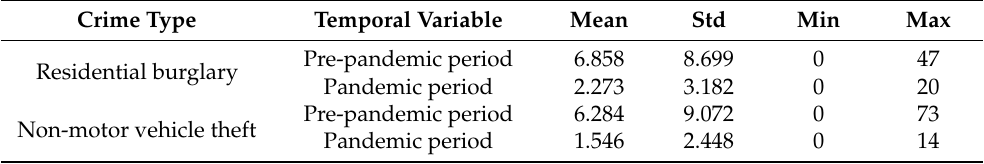
Table 2. Statistics of residential burglary and non-motor vehicle theft during the pre- and pandemic periods. Crime